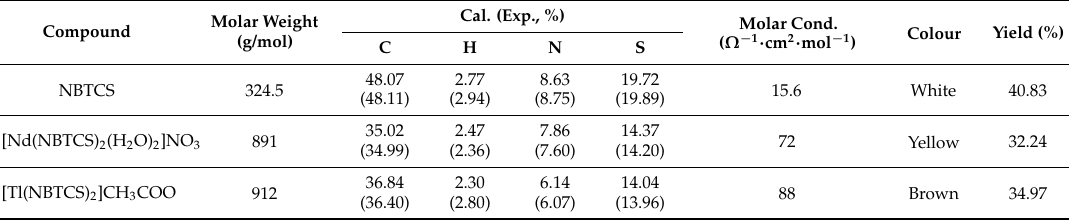
Table 1. Physical properties and elemental analysis of N -(Benzothiazol-2-yl)-4-chlorobenzenesulphonamide (NBTCS) and its complexes.